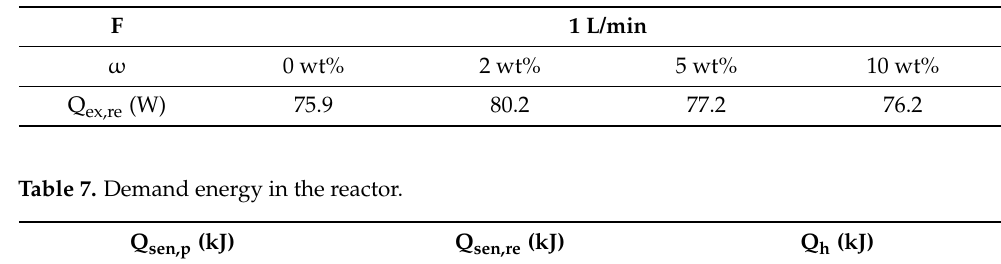
Table 6. Amount of heat exchange in the reactor.